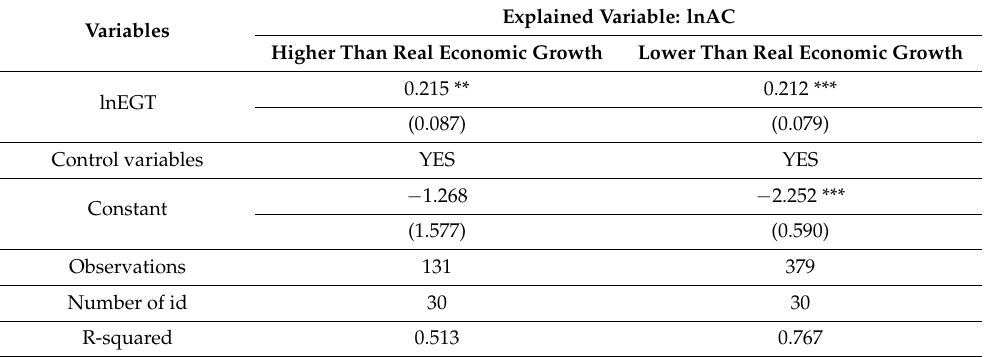
Table 5. Heterogeneity regression results of economic growth targets.